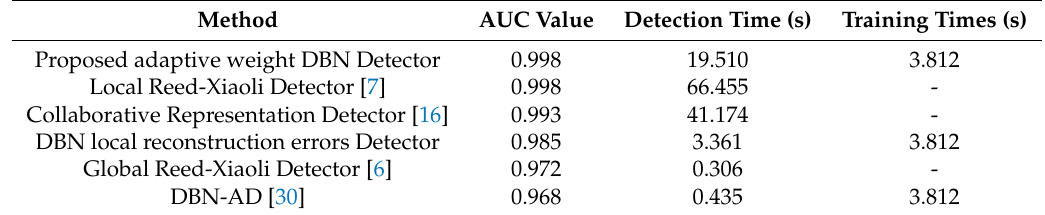
Table 3. AUC values and processing time of different methods for the Lake Salvador HSI image.